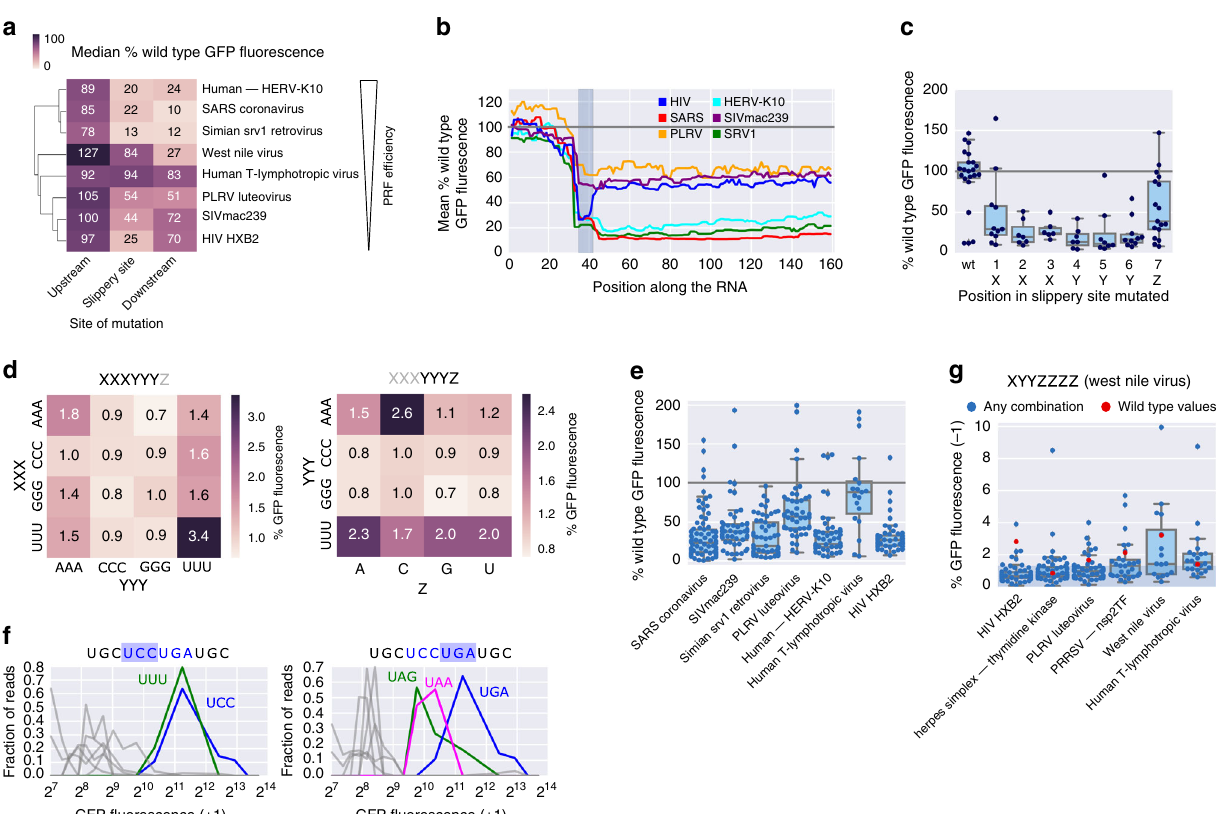
Fig. 2 Slippery sites are optimized for the respective frameshifting event. a Clustered heat map of median percent wild-type frameshifting of variants, in which the indicated region (upstream, slippery site (including the preceding codon) and downstream) differs from the native one ( n = 37 – 325). b The median percent wild-type PRF signal of variants, in which the indicated position is changed is plotted for the entire length of the variable region; gray box: slippery site. c Percent wild-type − 1 PRF signal for variants with a point mutation only in the indicated position of the slippery site; the box shows the quartiles of the dataset, while the whiskers show the rest of the distribution except for outliers ( n = 22, 11, 7, 6, 7, 8, 10, and 17 sequences tested, in the order they appear on the graph). d Heat map showing median percent GFP fl uorescence conferred by replacing the native slippery site in − 1 PRF sites tested positive in the assay (Fig. 1c), with the indicated combination of slippery site elements. e Distribution of percent wild-type GFP fl uorescence of variants, in which the slippery site was replaced by any possible combination of bases following the pattern XXXYYYZ; the box shows the quartiles of the dataset, while the whiskers show the rest of the distribution except for outliers ( n = 80, 49, 57, 48, 42, 19, and 56 sequences tested, in the order they appear on the graph). f Distribution of normalized reads across GFP ( + 1 frame) expression bins for variants of the OAZ1 frameshifting site, in which either the fi rst (left) or the second (right) codon is replaced; blue lines: wild type; green and magenta lines: bin pro fi le for the variant, in which the native codon was replaced by the indicated one; gray lines: bin pro fi les for other codons at this position. g Percent GFP fl uorescence for variants, in which the slippery site was replaced with all possible combinations of the slippery site pattern found in west nile virus (XYYZZZZ); the box shows the quartiles of the dataset, while the whiskers show the rest of the distribution except for outliers ( n = 54, 56, 51, 24, 16, and 22 sequences tested, in the order they appear on the Fig. 2a, Supplementary Fig. 5a) of the corresponding wild type. A similar pattern could be observed for SIVmac239. The HERV- K10 (refs. 31,32 ), SARS 30 , and SRV1 (ref. 33 ) PRF sites were highly sensitive to changes in both the slippery site and the downstream region, and in the case of HERV-K10 and SRV1 also showed a signi fi cant ( p = 0.0004 and 0.0023, respectively; Wilcoxon signed- rank test) reduction following changes in the upstream region (Fig. 2a, Supplementary Fig. 5b). It is noteworthy that the clus- tering of effects (although done on percent of wild-type PRF signal) resembles the wild-type PRF ef fi ciencies (Fig. 1c), with the most ef fi cient sites (HERV-K10, SARS, and SRV1) showing the